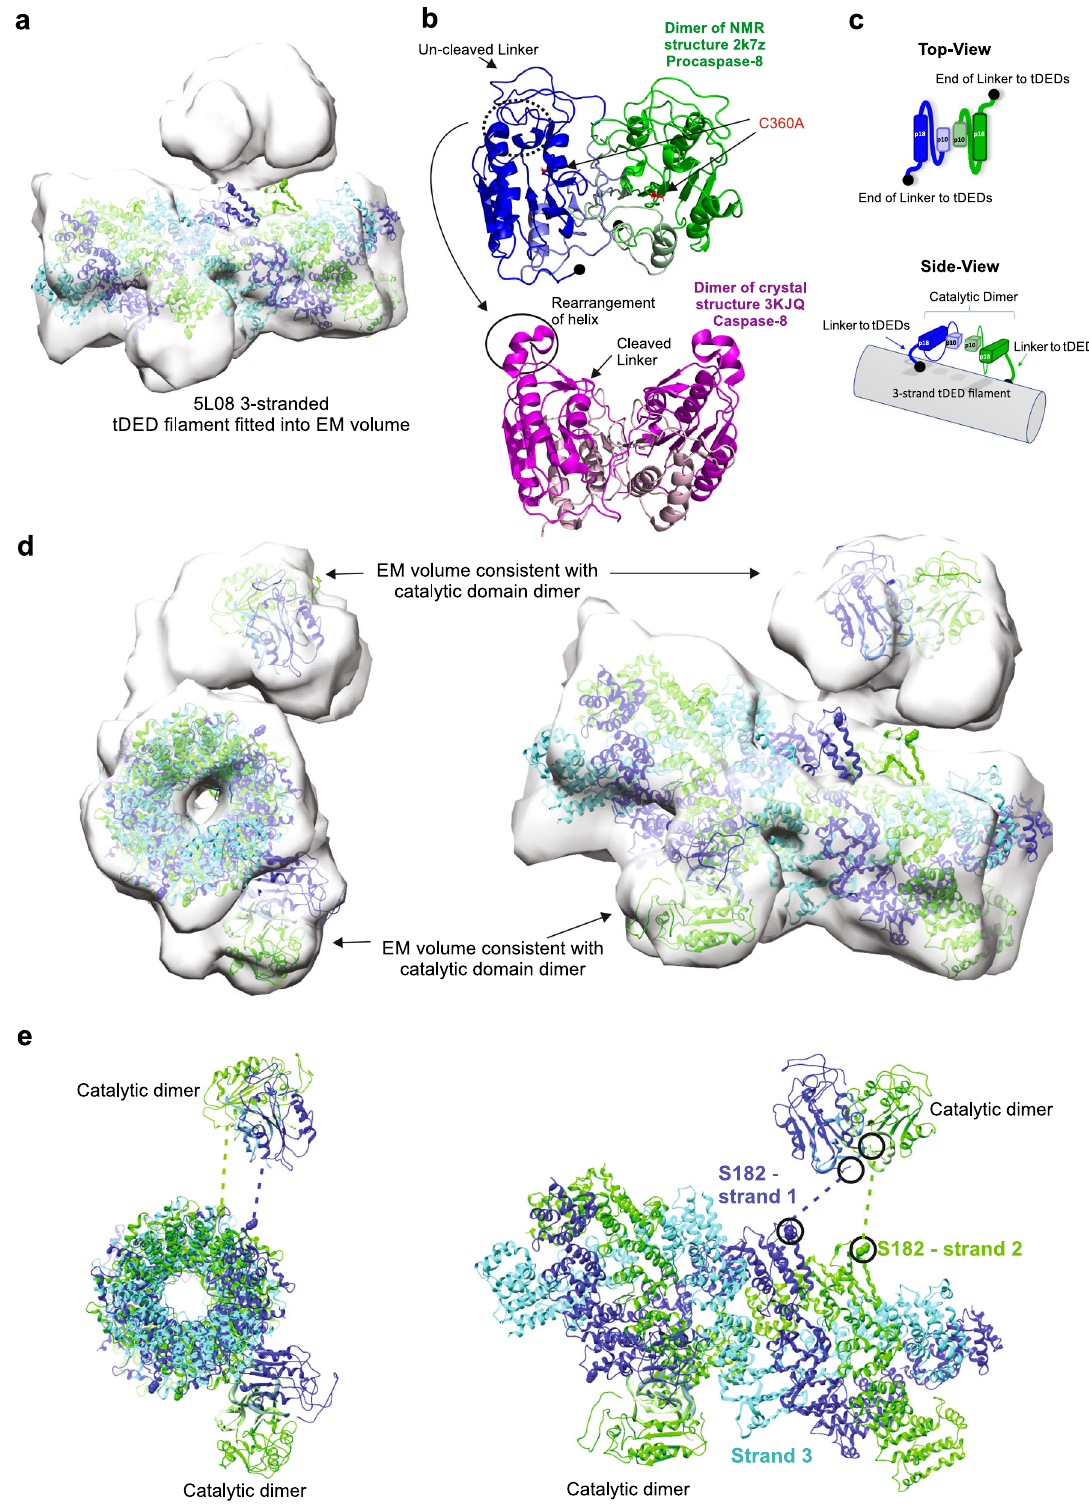
Fig. 3 Core tDED triple-helix facilitates inter-strand Caspase-8 catalytic domain anti-parallel dimerization. Re fi ned central region of full-length Caspase- 8 fi lament with, a published tDED-only structure (5L08; 12 ) fi tted as a rigid body. b Ribbon NMR-based structural model of dimerized uncleaved catalytic subunit domains (2k7z; 21 ; upper panel, C360A in red and K224 as fi lled circle) and ribbon X-ray structure of cleaved catalytic subunit dimer (3KJQ; 14 ; lower panel). c Schematic representation of uncleaved Caspase-8 p18 (large) and p10 (small) catalytic domains in anti-parallel orientation relative to tDED domains. d Fitted ribbon diagram of Caspase-8 tDEDs and catalytic domain assembly. Each strand of the helix is coloured; blue and green strands contain aligned DEDs, while in the cyan strand the DEDs are offset. e Caspase-8 catalytic domain subunit colours re fl ect the DED strand from which they originate. Distance between the termini connected by the dashed lines is approximately 35 Å, which can be accommodated by the 32 amino acid fl exible linker between the tDED and catalytic domains of